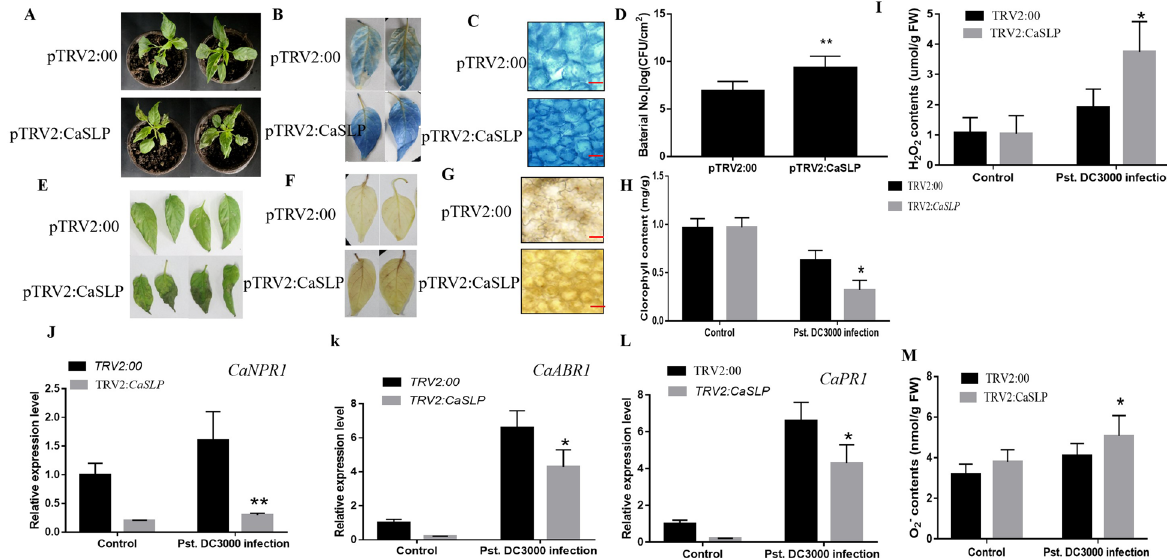
Fig. 7 Silencing of CaSLP by virus-induced gene silencing (VIGS) decreases Pst.DC3000 resistance in pepper. A , E Disease symptoms of CaSLP -silenced and control (TRV, tobacco rattle virus) plants before and after the Pst.DC3000 infection. Plants were infected with Pst.DC3000 for 3 days. B , F Histochemical staining with 3,3’-diaminobenzidine (DAB) and Trypan blue for analyzing the accumulation of H 2 O 2 in the CaSLP -silenced and control plants before and after 3 d of Pst.DC3000 infection. C , G Trypan blue and DAB staining for cell death in the CaSLP -silenced and control plants before and after Pst.DC3000 infection. Bar 50 μm. D - I Bacterial numbers ( D ), Chlorophyll content ( H ), and H 2 O 2 content ( I ) of the = CaSLP -silenced and control plants before and after 3 d of Pst.DC3000 infection. J - L The expression of the SA response genes of CaNPR1, CaABR1 and CaPR1 . M, O 2. − content of the CaSLP -silenced and control plants before and after Pst.DC3000 infection. Error bars represent SD ( n 3). Asterisks ± = indicate a significant difference between CaSLP -silenced and control plants(*, P < 0.05; **, P <